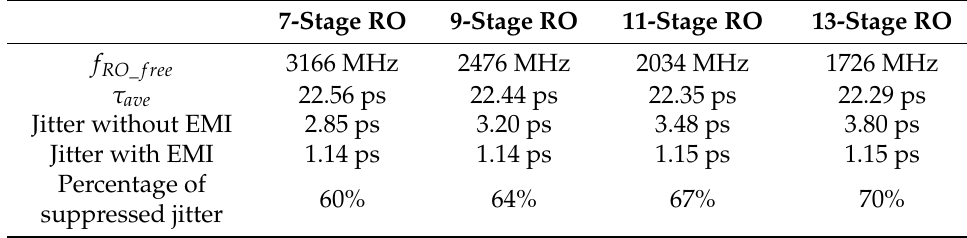
Figure 9. Interference experiment of the RO-based TRNG. ( a ) Output bitstream of the RO-based TRNG without EMI; ( b ) period distribution of the RO without EMI; ( c ) output bitstream of the RO-based TRNG with EMI; ( d ) period distribution of the RO with EMI. Table 2. Behavioral parameters of the RO in the RO-based TRNG with and without